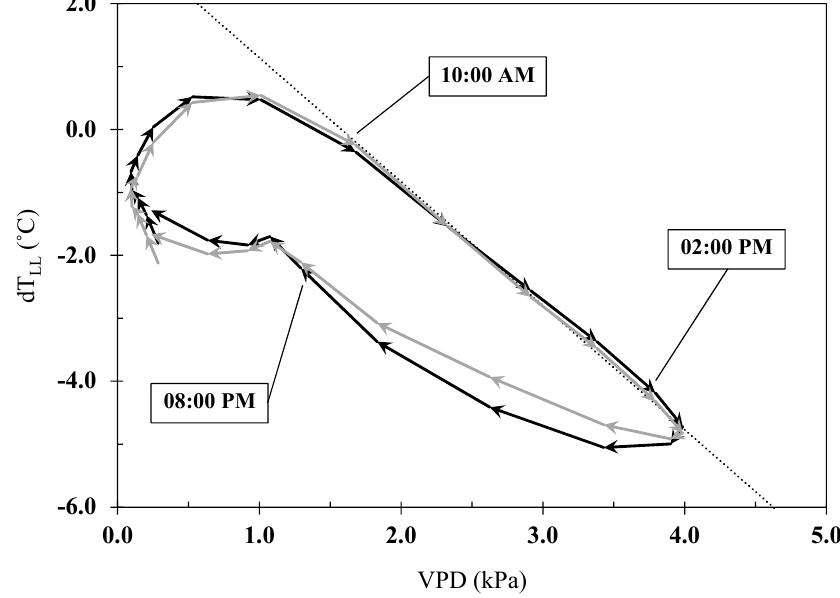
- vs .-VPD for plots L-1.1 (black arrows) and L-1.2 Figure 2. Graphs of hourly dT LL (gray arrows), overlaid on maize non-water-stressed baseline (dotted black) of Idso